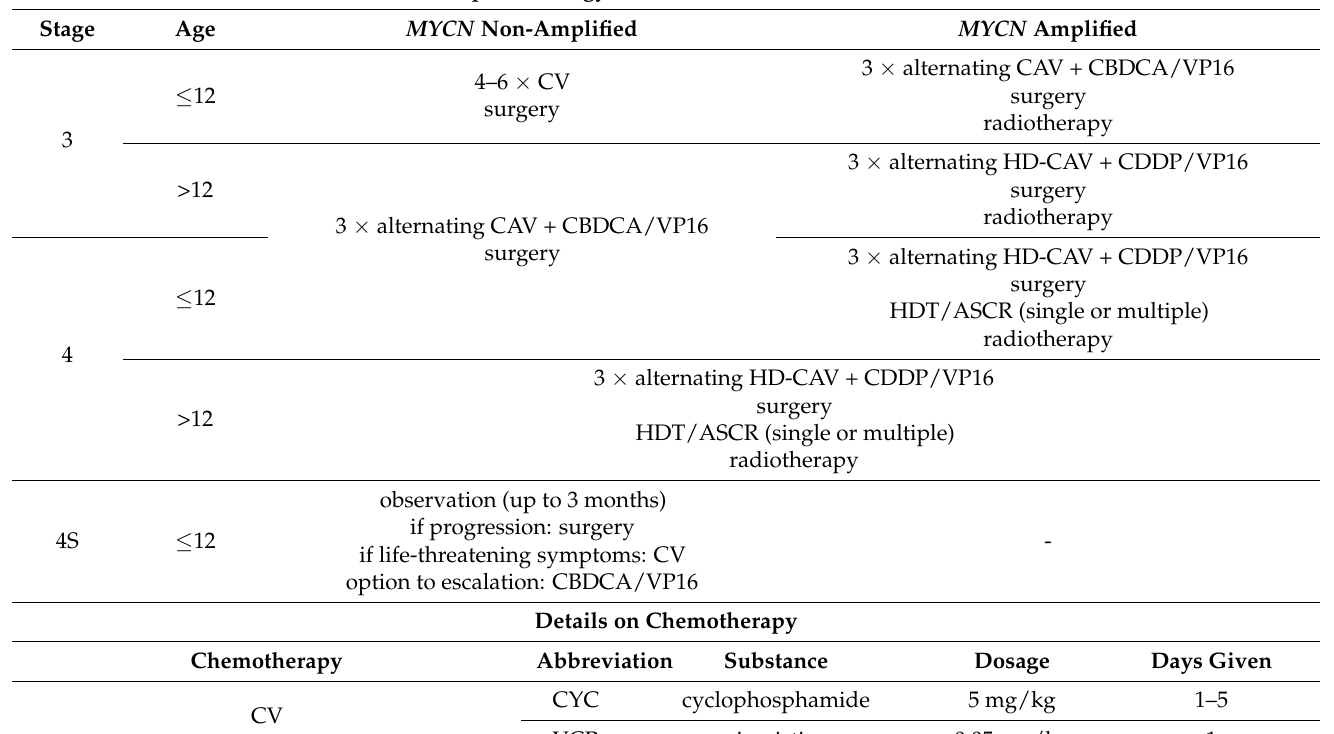
Table 1. Cont. Risk-Adapted Strategy of Treatments in the A-NB94